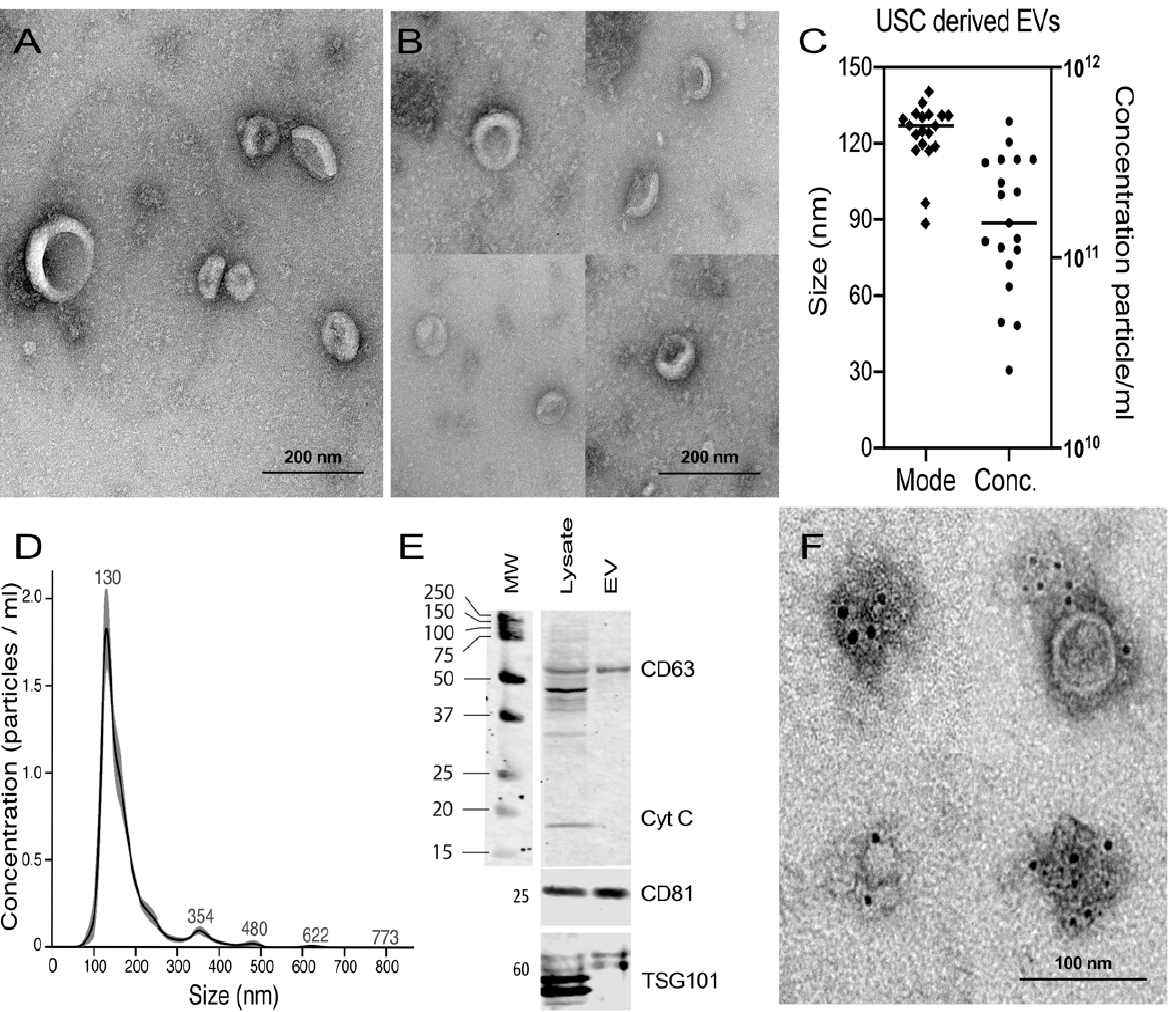
Figure 3. Characterization of USCs–derived EVs; ( A , B ) TEM negative staining of the isolated EVs showing cup–shaped vesicles with an average size of 110 nm visualized at lower magnification ( A ; Mic. Mag. × 23,000) and higher magnification ( B ; Mic. Mag. × 30,000) (2%Uranyl Acetate). ( C ) Histogram presentation of 19 EVs pellets collected from 1.6 × 10 7 USCs analyzed for size and concentration, showing an average size of 122 nm and an average concentration of 1.90925 × 10 11 . ( D ) Size distribution curve of USCs isolated EVs particle concentration ( × 10 7 ) vs. particle size mode, measured by nanoparticle tracking analysis (NTA) showing the average of the six technical replicate measurements for each exosome isolation by NanosightS300. ( E ) Western blot of USCs cell lysate and isolated the EVs for CD63, CD81, TSG101 antibodies as positive markers for EVs and Cytochrome C as mitochondrial membrane marker (cellular Marker) and negative marker for EVs. ( F ) Immune gold staining of the isolated vesicles for CD63 using 6 nm gold nanoparticles (2% Uranyl Acetate, scale bar = 100nm, Mic. Mag. ×30,000 (upper left) and ×23,000 rest).